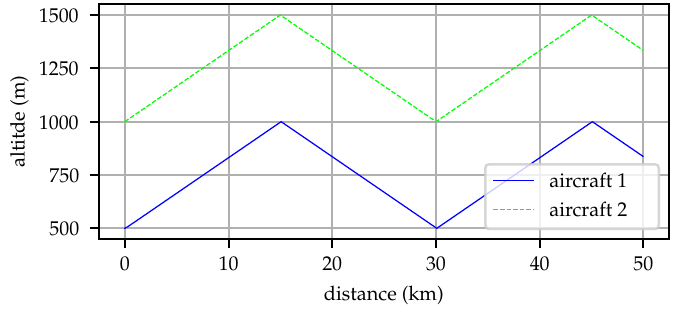
Figure 5. Flight paths taken by the two simulated aircraft for a simulation beginning at 16:00 UTC on 2018-12-03. One aircraft remains between 500 and 1000 m while the other stays between 1000 and 1500 m so neither can independently sample the region of